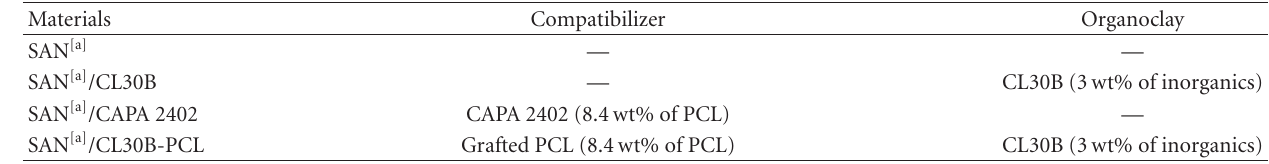
Table 1: Description of the studied materials.